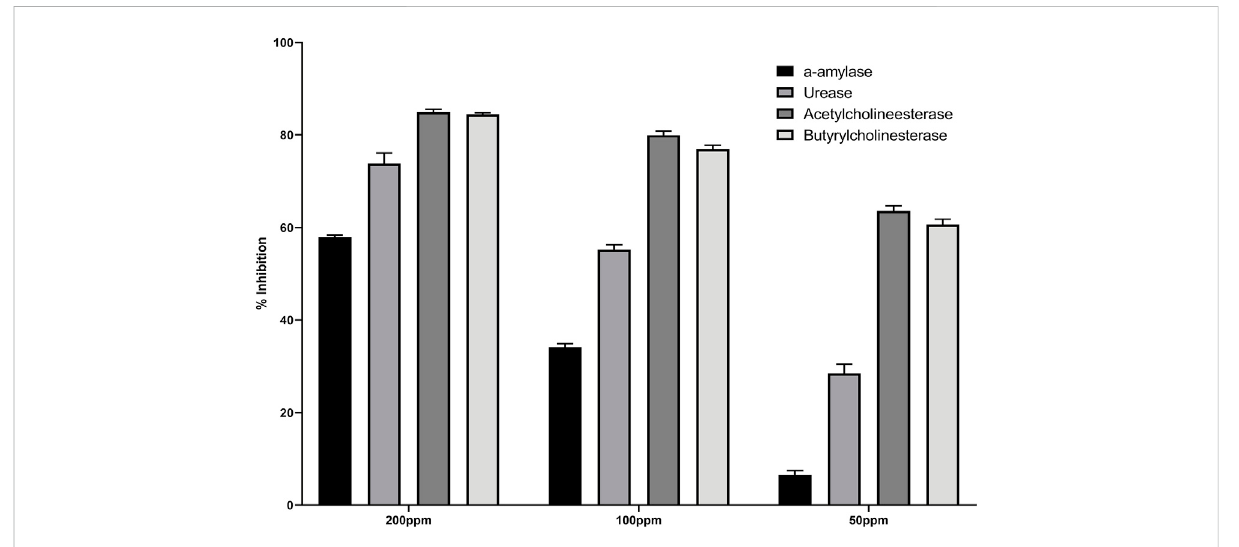
FIGURE 2 Percentage inhibition of (3) against different enzymes.